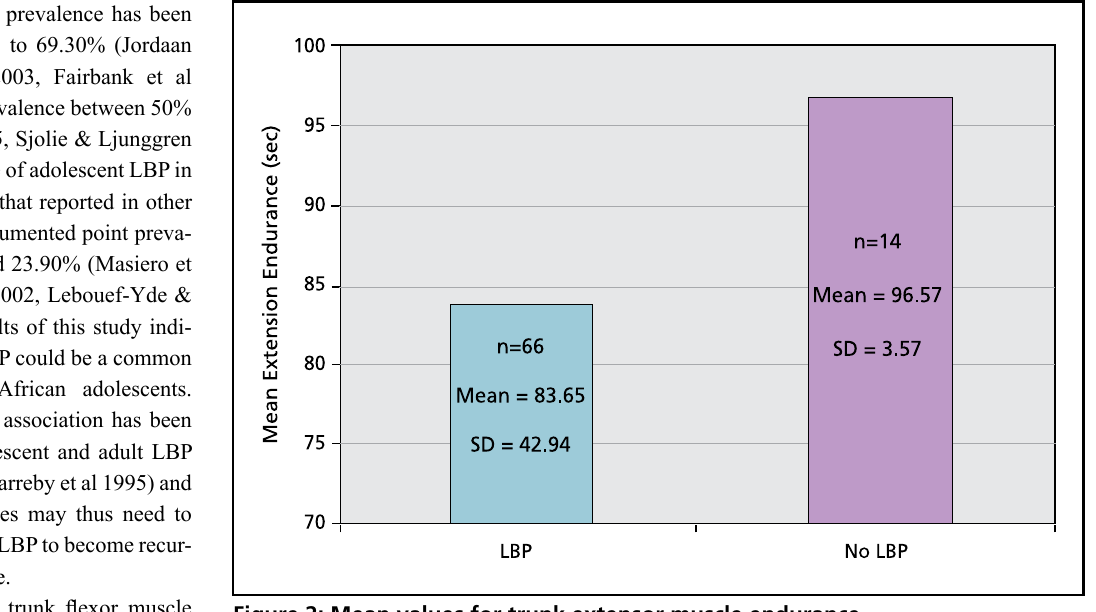
Figure 2: Mean values for trunk extensor muscle endurance